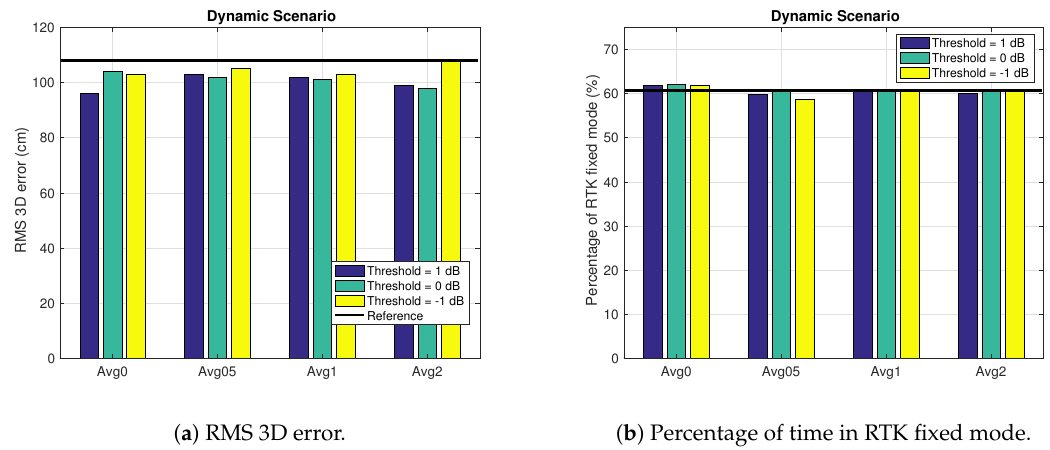
Figure 16. Results in the Dynamic scenario for different exclusion thresholds and average configurations.